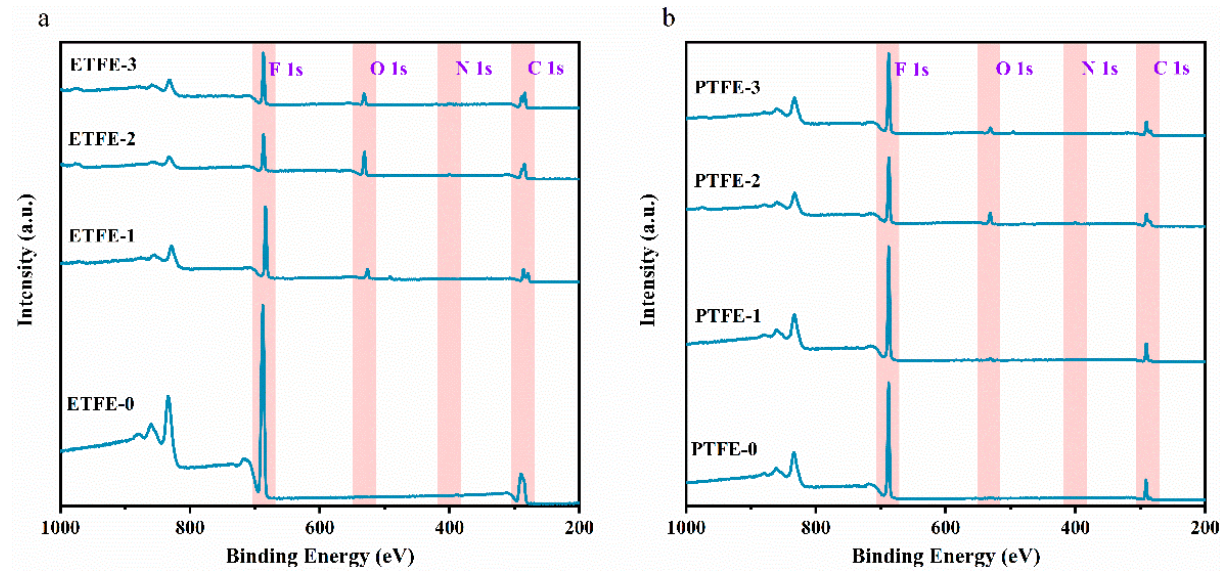
6 of 15 Figure 4. Comparison of IR PiFM spectra of membrane surface before and after treatment: ( a ) ETFE- 0 membrane, ( b ) ETFE-3 membrane, ( c ) PTFE-0 membrane, and ( d ) PTFE-3 membrane. 3.2. XPS Analysis XPS was used to characterize the elemental concentration of the ETFE and PTFE membrane surfaces before and after plasma treatment. From Figure 5a and Table 2, it can be seen that the O element peak can be observed on the surface of the ETFE-1 membrane after helium plasma modification compared to the ETFE-0 membrane, the O element con-